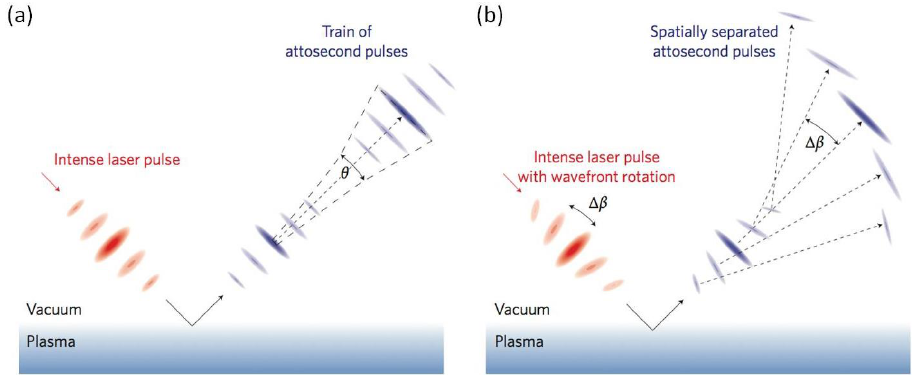
Figure 5. Asec lighthouse effect for few-cycle laser-driven plasma mirrors. ( a ) When an intense few-cycle laser pulse interacts nonlinearly with a plasma mirror, the sub-cycle modulation of the temporal laser wavefronts is associated with the generation of a train of asec light pulses, which all propagate in a collimated beam along the direction normal to the laser wavefronts at focus. ( b ) When the laser wavefronts are made to rotate in time at focus (WFR), each asec pulse of the train is emitted in a slightly different direction. From Ref. [67].